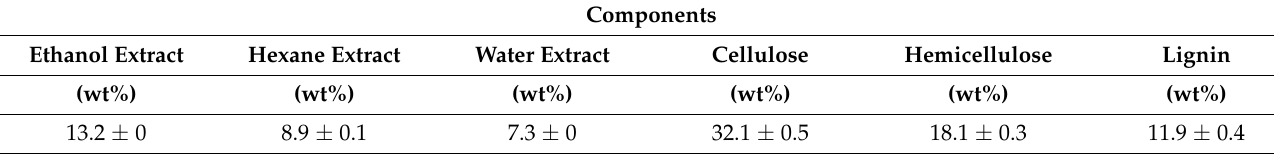
Table 10. Components of Jordan’s corn leaf waste sample